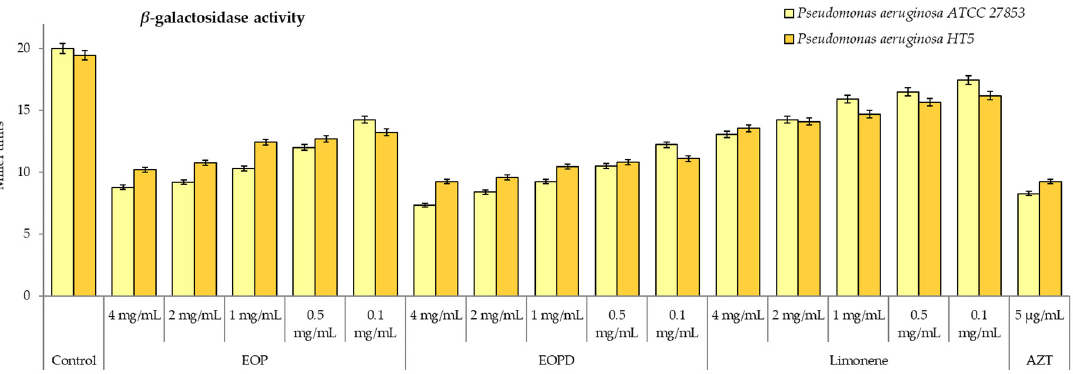
Figure 7. The β -galactosidase activity of Pseudomonas aeruginosa ATCC 27853 and HT5 strains. EOP: Essential oil obtained by cold-pressed method; EOPD: essential oil obtained by cold-pressed method followed by steam distillation; L: limonene; AZT: azithromycin. Data are presented as means ± SEMs ( n = 8) of three independent experiments. All experiments show significant differences compared to respective controls ( p < 0.05).